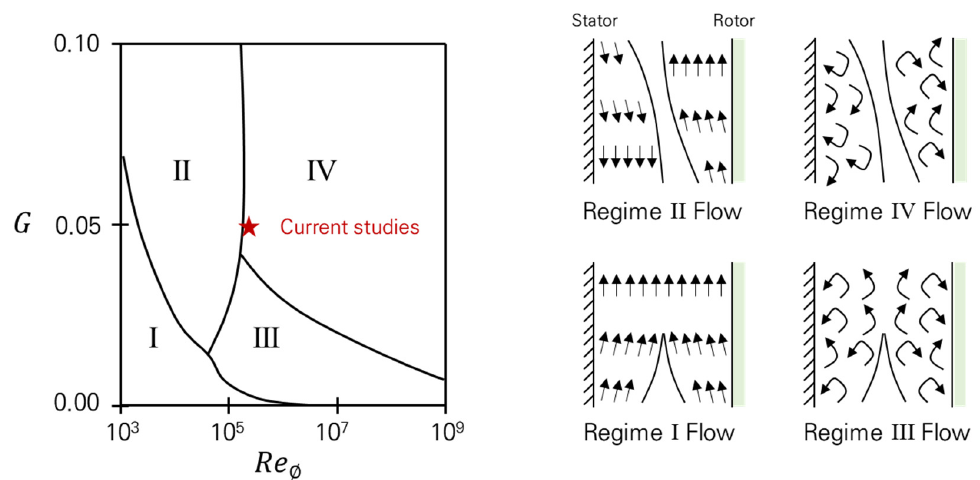
Figure 1. Rim seal experimental conditions and flow regimes [41].